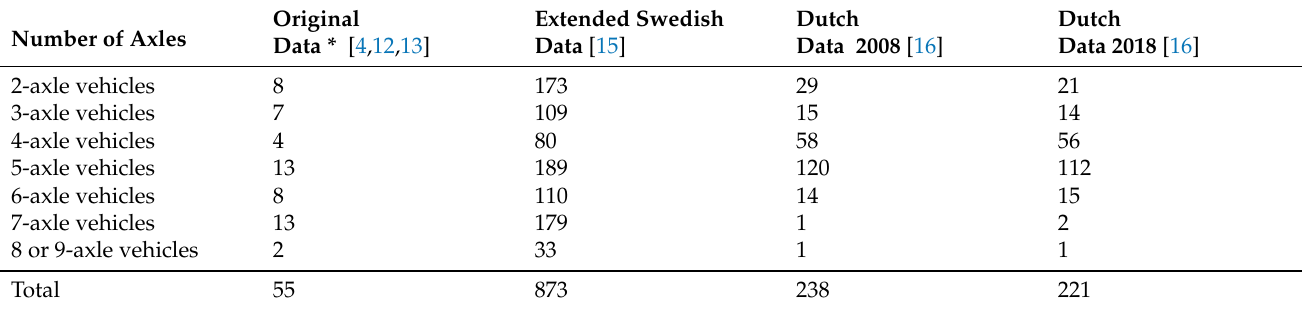
Table 1. Number of lorries in each data pool × 10 3 .